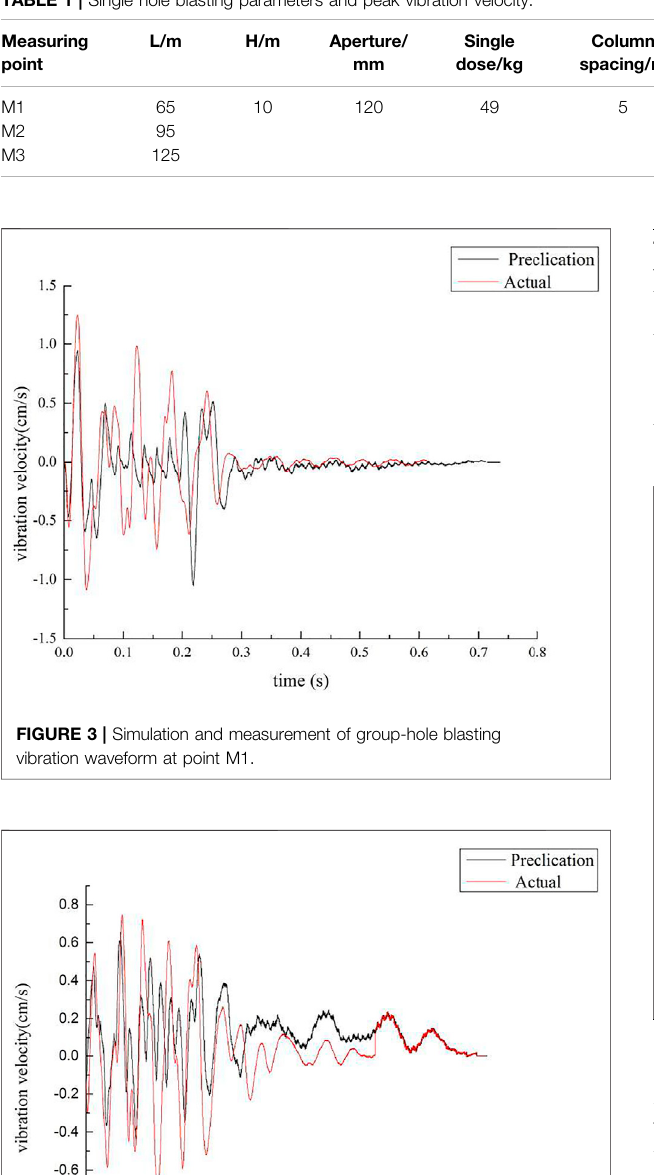
TABLE 1 | Single hole blasting parameters and peak vibration velocity.